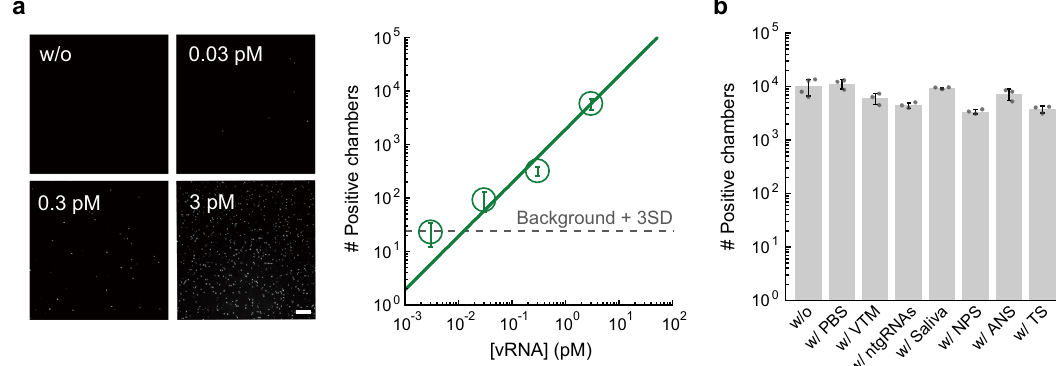
Fig. 4 Practicability of SATORI for clinical applications. a Digital detection of RNA extracted from SARS-CoV-2 virus (vRNA). The representative fl uorescence images and the number of positive chambers, obtained with the crRNA-CoV-N1 at different concentrations of vRNA, are shown. b Effects of contaminants on SATORI. SATORI assays were performed with the crRNA1 and the tgRNA1 in the presence of 10% PBS, 70% virus transport medium (VTM), 3 ng/ μ L nontarget RNAs (ntgRNAs), 10% saliva, nasopharyngeal swab (NPS), anterior nasal swab (ANS), or throat swab the removal of the remaining photoresist by sequential rinses with acetone, 2-propanol, and pure water. The quality of the devices was evaluated with the aforementioned laser microscope. Devices with hole-diameters of 2.5 ±0.2 μ m were selected and used for our experiments (Supplementary Fig. 1). A fl ow cell was constructed on the device, by attaching a U-shaped frame chamber seal (SLF0601, Bio-Rad) and a custom-made glass block with an inlet port (Tsubaki Glass Kogyosyo) (Supplementary Fig. 1).